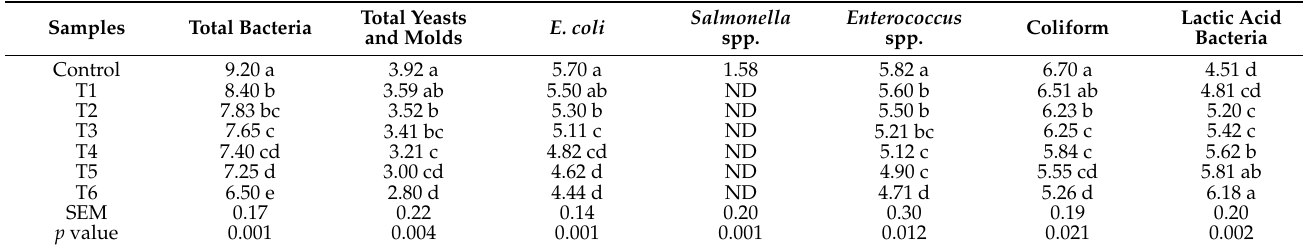
Table 8. Cecal microbiota (total bacteria, yeasts and molds, E. coli , coliform, Salmonella spp., Enterococcus spp., and lactic acid bacteria) are represented (Log CFU/g) broiler during feeding as affected by dietary supplementation of ZnNPs, CurNPs, and Bacillus licheniformis . ( n =